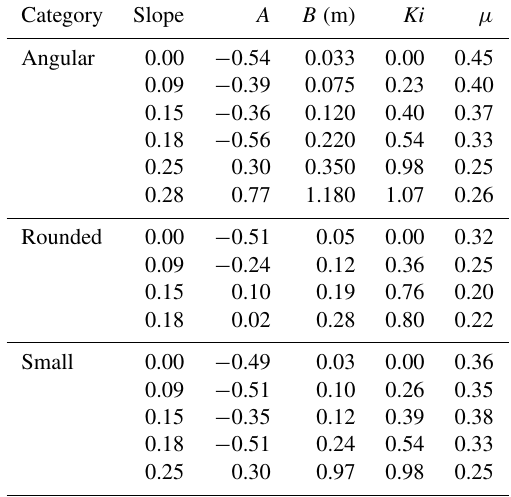
Table 2. Fitted and estimated parameter values for travel distance experiment data shown in Fig. 7. A and B are the estimated shape and scale parameters from data fit by eye with generalized Pareto distributions. The Kirkby number Ki is equal to S/µ , where µ is the friction